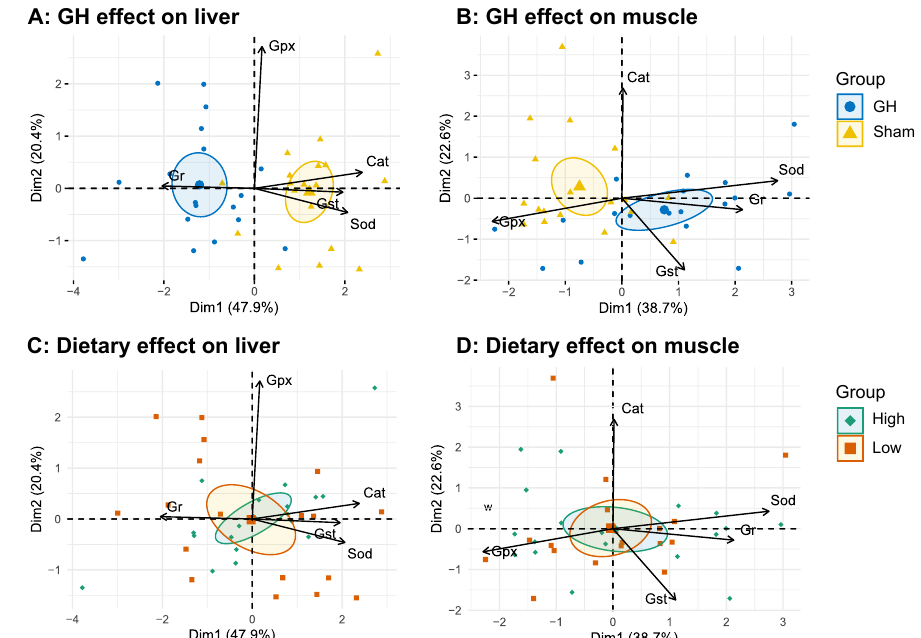
Figure 7. PCA biplots on specific antioxidant enzyme activity grouped by GH ( A , B ) or dietary vitamins C and E feeding ( C , D ) measured in liver and muscle, respectively. Arrows represent the 5 most contributing variables to the model, respectively (Cat, catalase; Sod, superoxide dismutase;